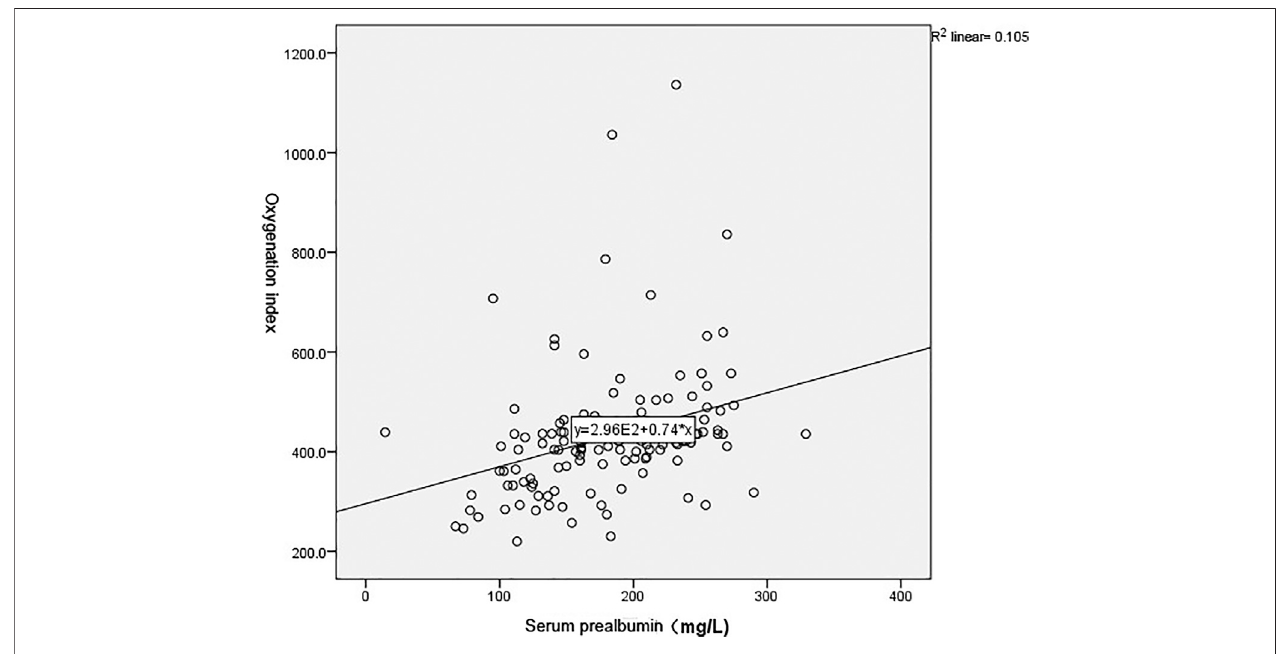
FIGURE 1 | Correlation between serum prealbumin and oxygenation index.